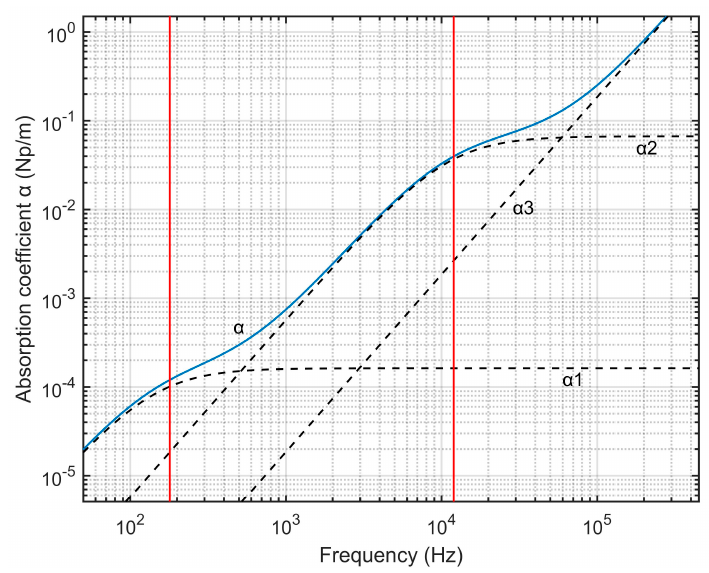
Figure 2. Attenuation of sound in air as a function of frequency (log-log plot).